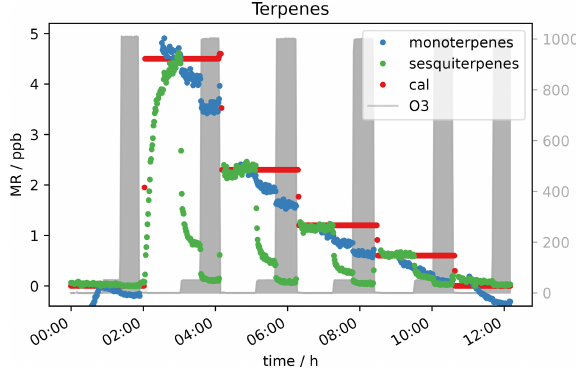
Figure 7. Different terpene levels at 0, 50 and 1000ppb O 3 mea- sured with